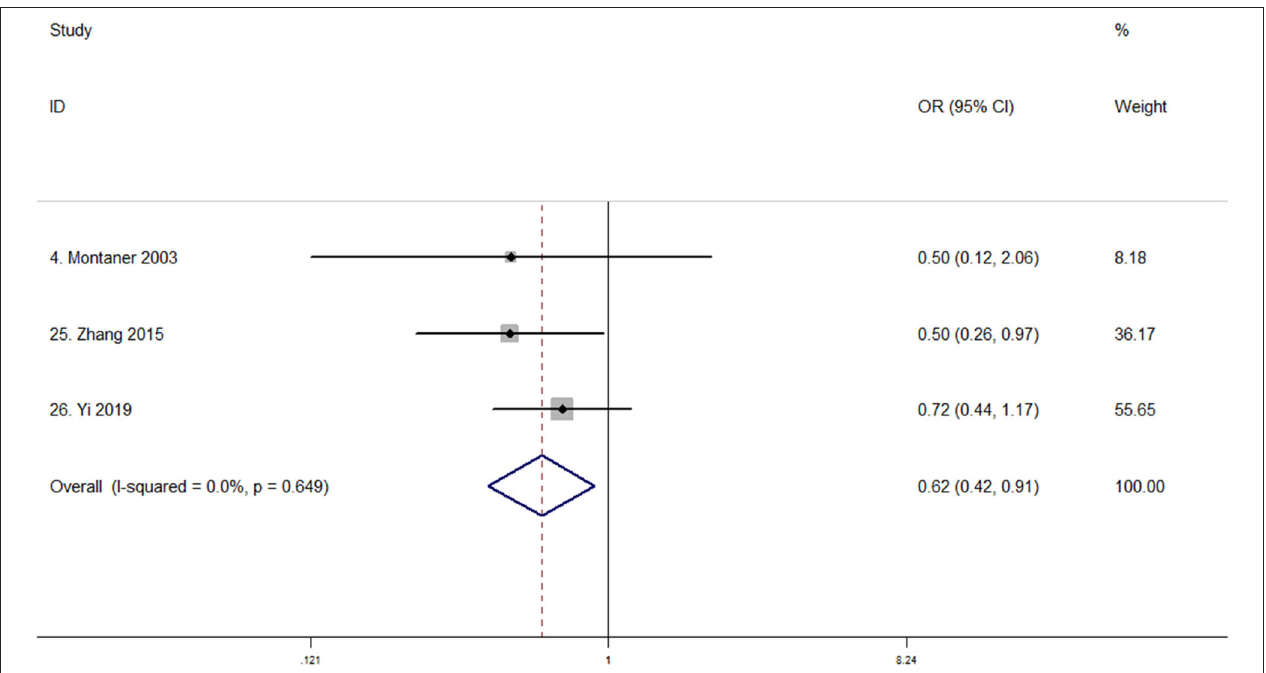
FIGURE 4 | Forest plot of the association between MMP-9 rs3918242 polymorphism and hemorrhagic transformation susceptibility (TT + CT vs. CC). OR, odds ratio. Studies are numbered according to Table 2